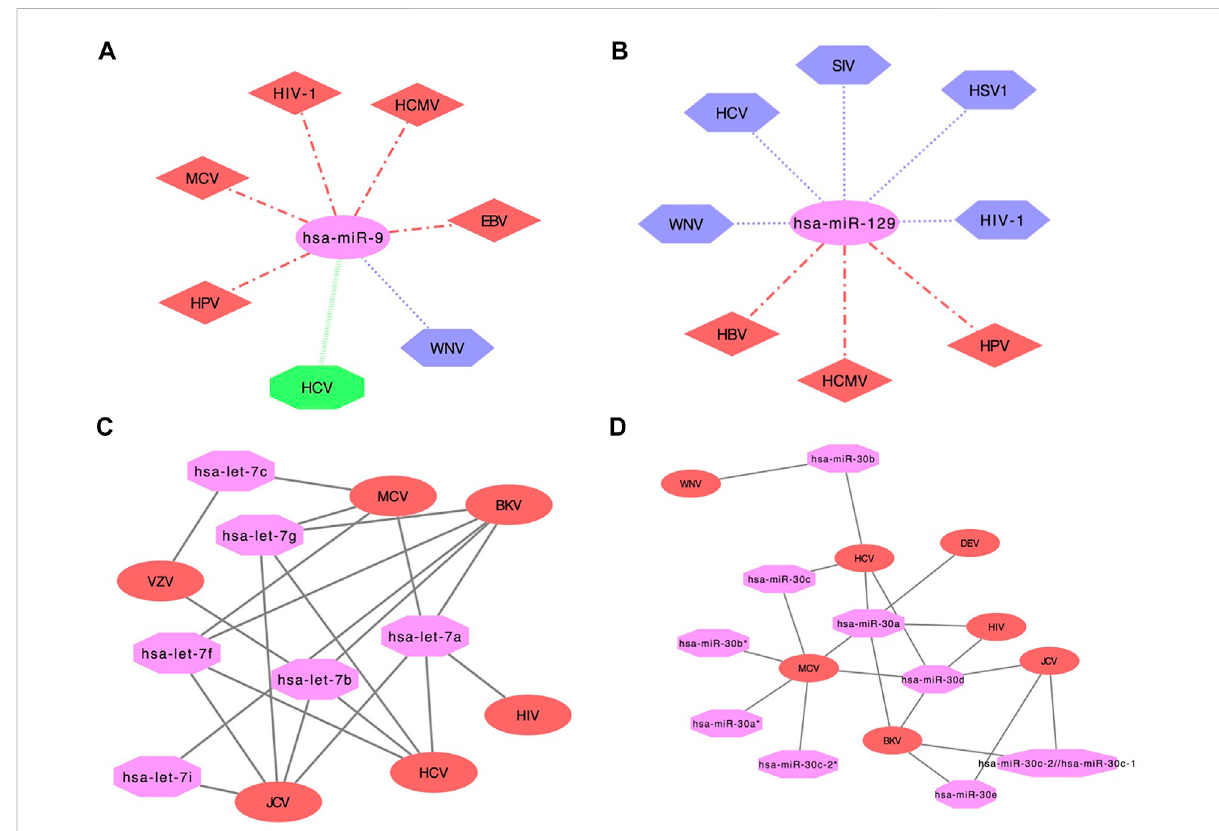
FIGURE 4 Network showing human miRNA expression reported in different viruses in ‘ DEmiRVIR ’ (A) hsa-miR-9 and (B) hsa-miR-129 (Viruses with hexagonshape(purplecolor)representdownregulation,diamondshape(redcolor)representsupregulation,octagonshape(greencolor)represents viruses found common in both upregulation as well as downregulation in different studies and miRNA is represented in ellipse shape (pink color)). Network interaction analysis for ‘ AntiVmiR ’ (C) let-7 and (D) mir-30. Virus name is written in ellipse shape (red color) and miRNA name in octagon shape (pink